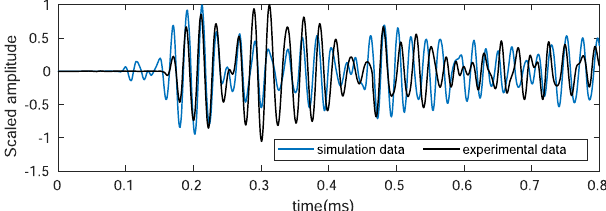
Figure 8. Comparison of the experimentally recorded (black) and numerically simulated (blue) acceleration, for source eleva- tion of 82 (cid:3) . The amplitude of the reverberated part of the experimental data is scaled as in Figure